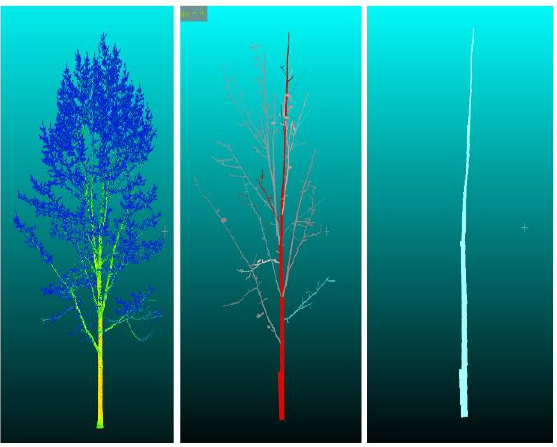
Figure 5. Extraction of main stem